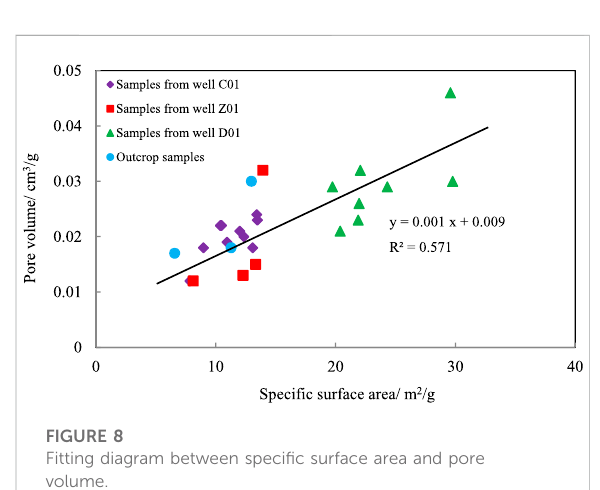
FIGURE 8 Fitting diagram between speci fi c surface area and pore volume.